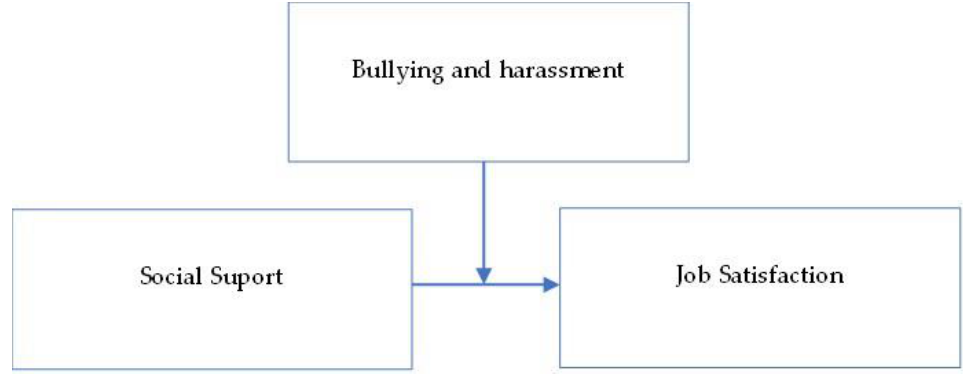
Figure 1. Conceptual moderation model for the relationships between the study variables.